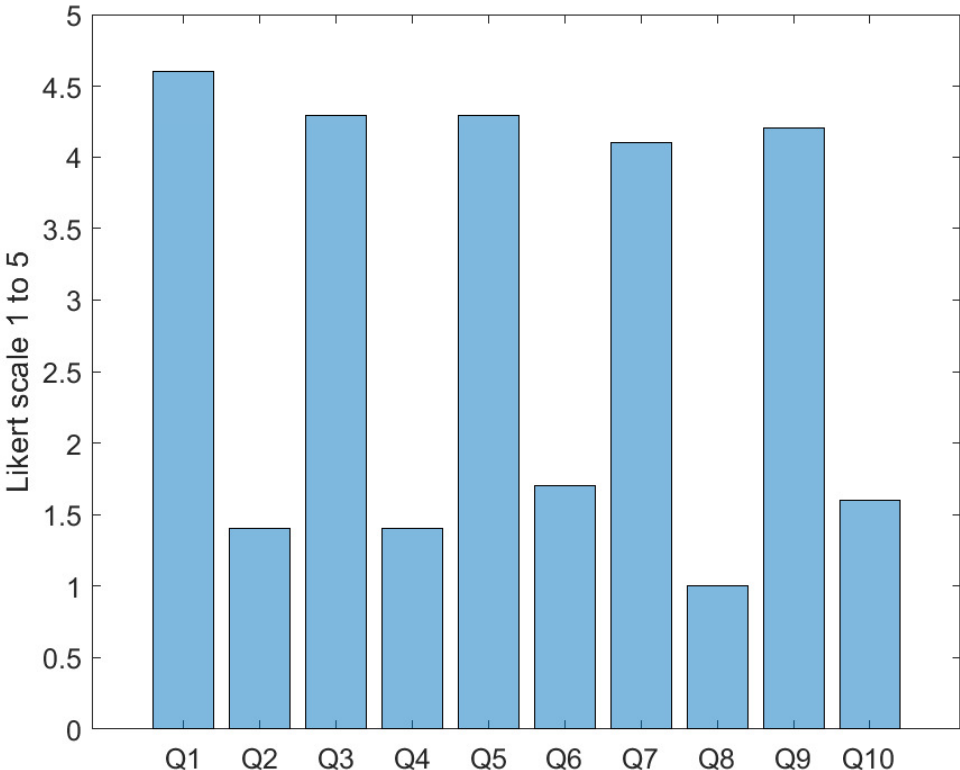
Figure 12. SUS questionnaire results per question. 1 = strongly disagree, 5 = strongly agree.